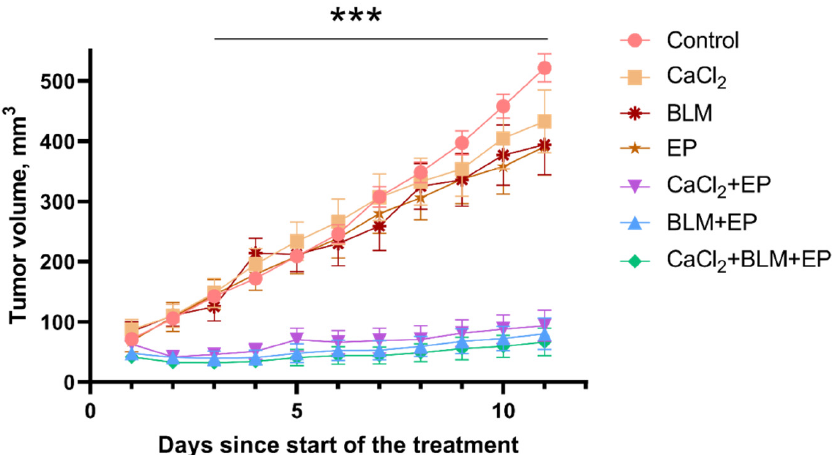
Figure 3. The bystander effect on 4T1 cells induced by bleomycin electrotransfer and calcium elec- troporation. ( A ) Cell viability after cell incubation in CM taken from untreated cells and cells ex- posed to ( B ) bleomycin (20 nM) electrotransfer or ( C ) calcium (1 mM) electroporation using a single 100 µs duration pulse at 1400 V/cm pulse strength. ( D ) Cell viability depending on CM dilution and mixing. The mean represents 3 independent experiments with 3 repetitions. * and *** symbols rep- resent statistical significance of comparison between corresponding experimental group and con- trol, respectively ( p < 0.05 and p < 0.001).